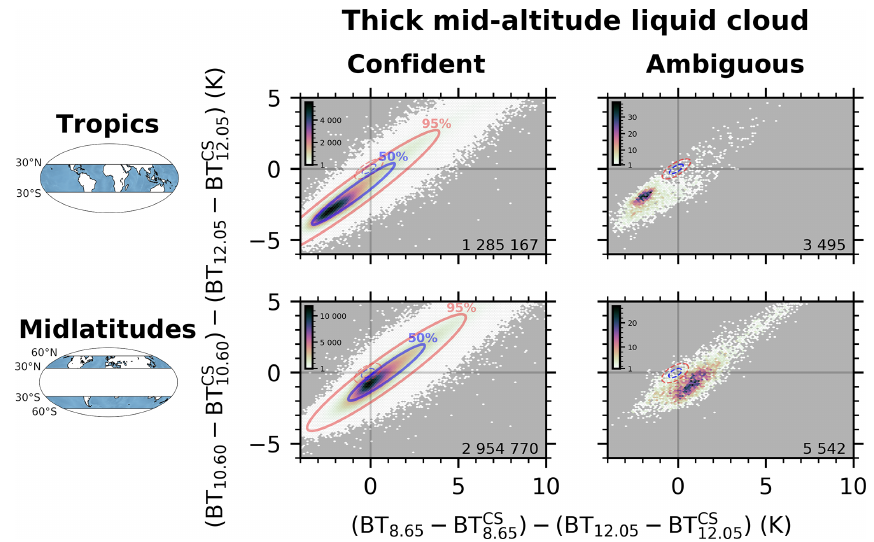
Figure C2. As Fig. C1 for liquid cloud monolayer observations with τ > 3 and 4km < z top <